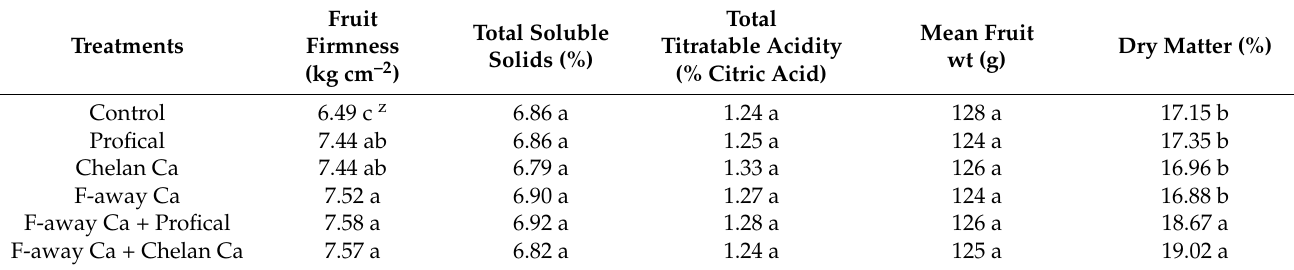
Table 3. Kiwifruit weight, fruit firmness, total soluble solids, total titratable acidity and dry matter during harvest (means of 2